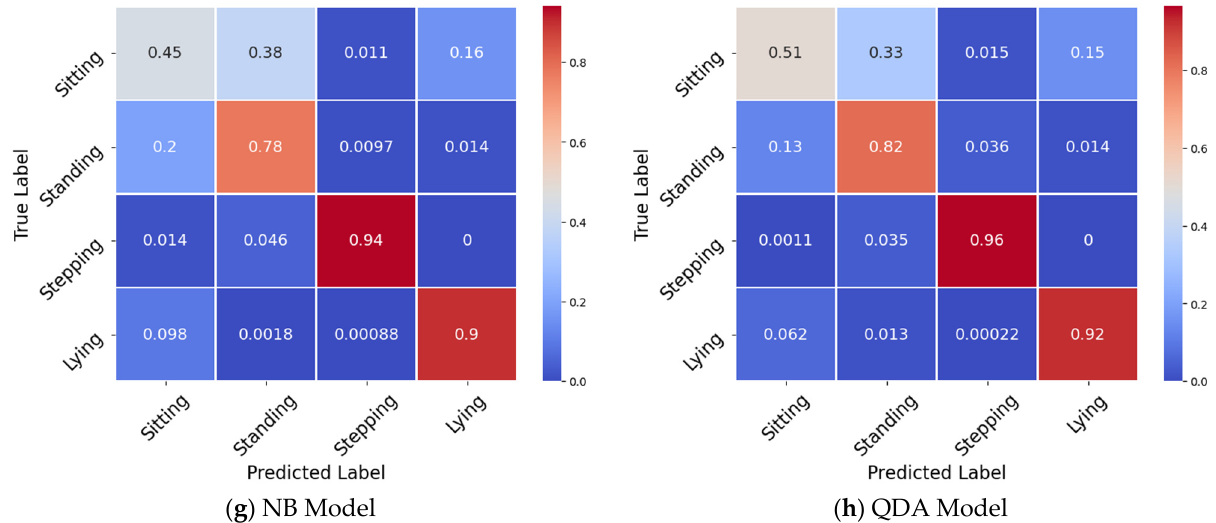
Figure 3. Confusion matrices for each classifier utilizing a 15 s window length: ( a ) KNN, ( b ) LDA, ( c ) SVM, ( d ) RF, ( e ) ET, ( f ) LR, ( g ) NB, and ( h ) QDA.